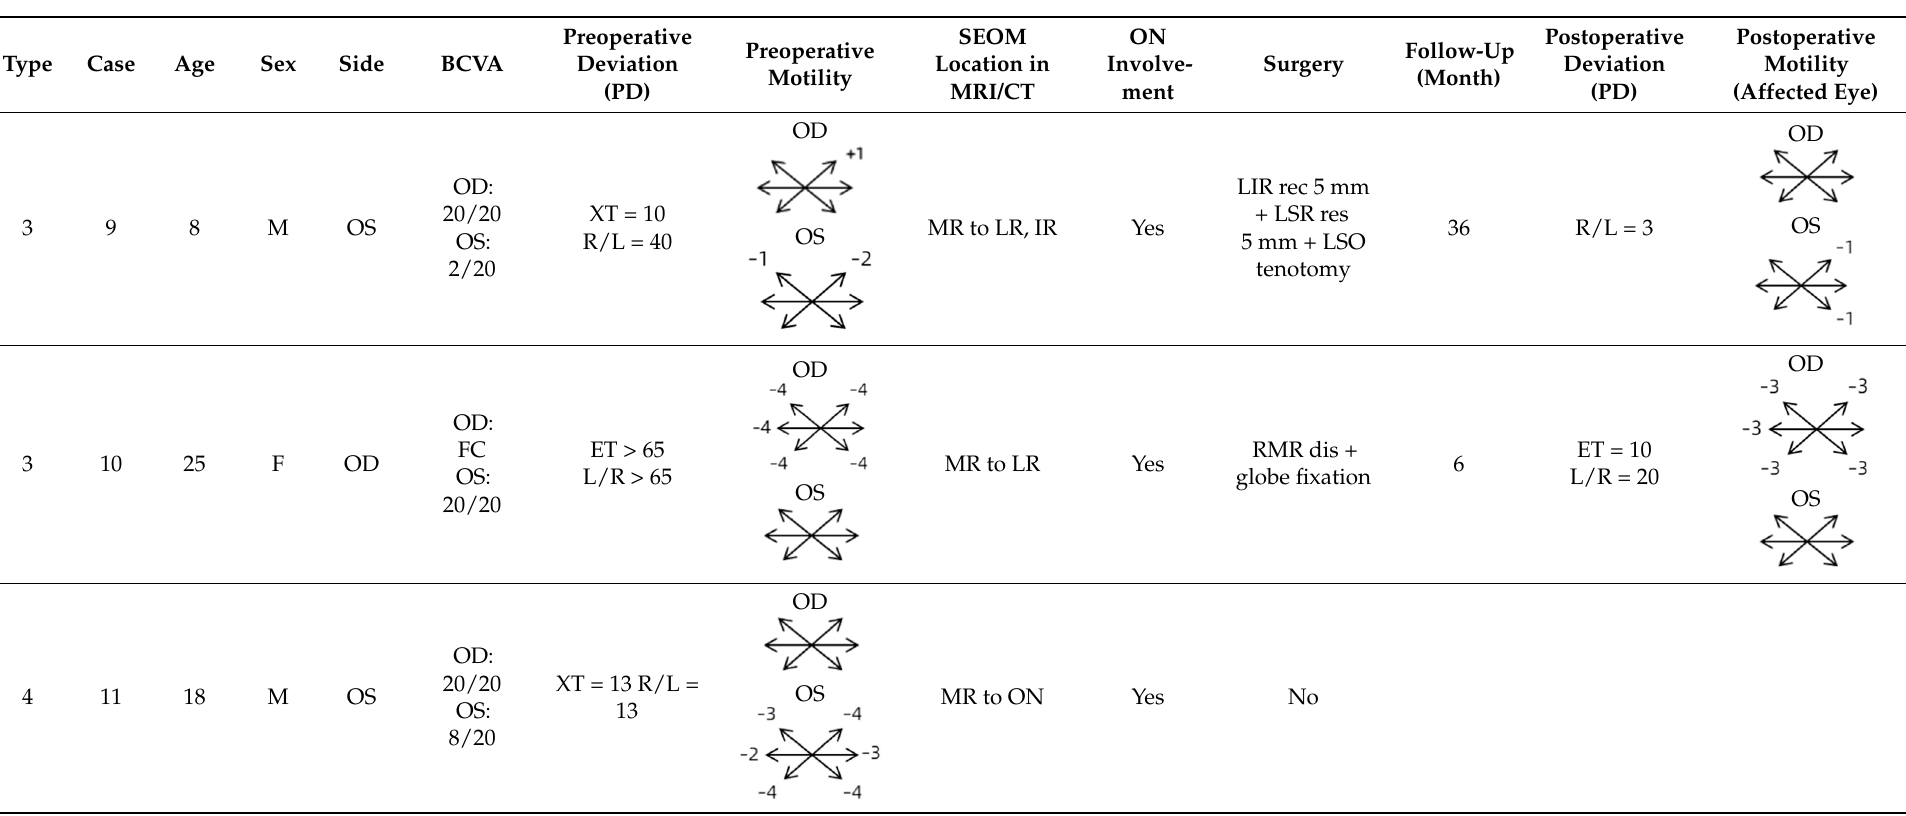
Table 1. Clinical characteristics and surgical results in 12 patients with supernumerary extraocular